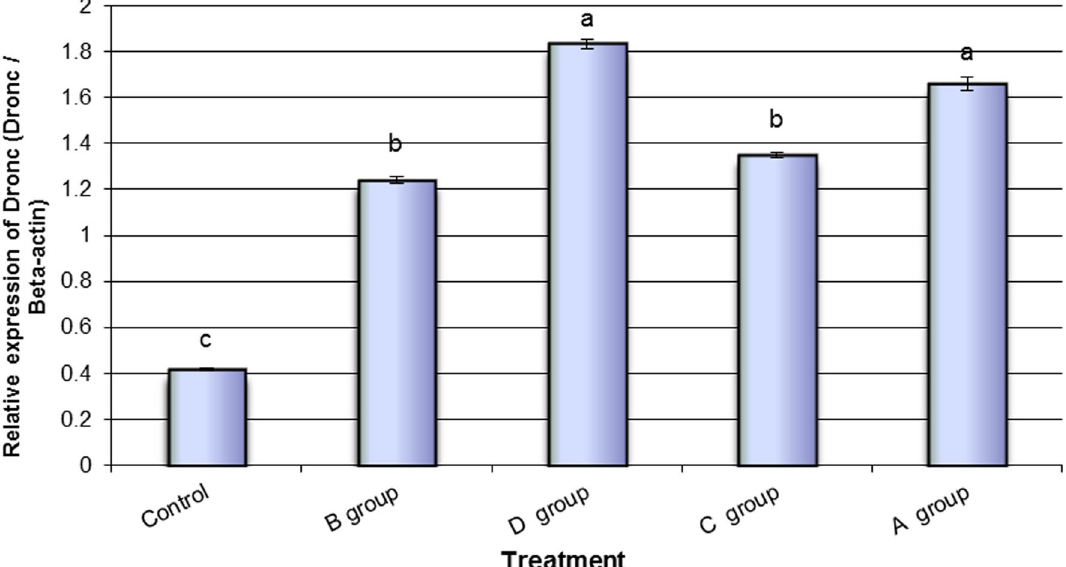
Fig. 2 The expression of the Dronc gene is altered in insect tissues that have been exposed to various bacterial bio‑insecticides. Data are displayed as mean SEM. Within tissues, mean values with dissimilar superscript letters showed a statistically significant difference (a: P0.01, b: